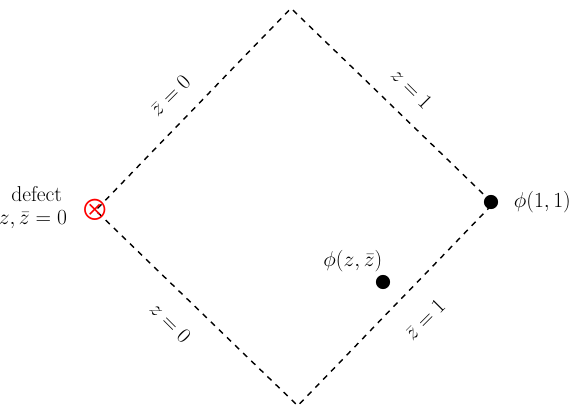
(cid:30) ( x 1 ) (cid:30) ( x 2 ) . We show a two-dimensional plane, h i